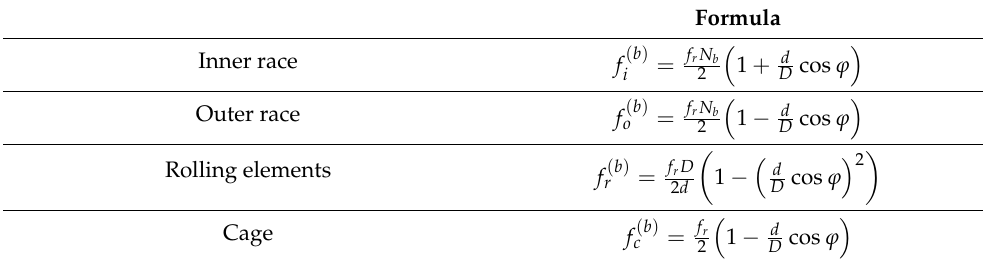
Table 6. Fault characteristic frequency of bearing supporting fixed-axis gear or